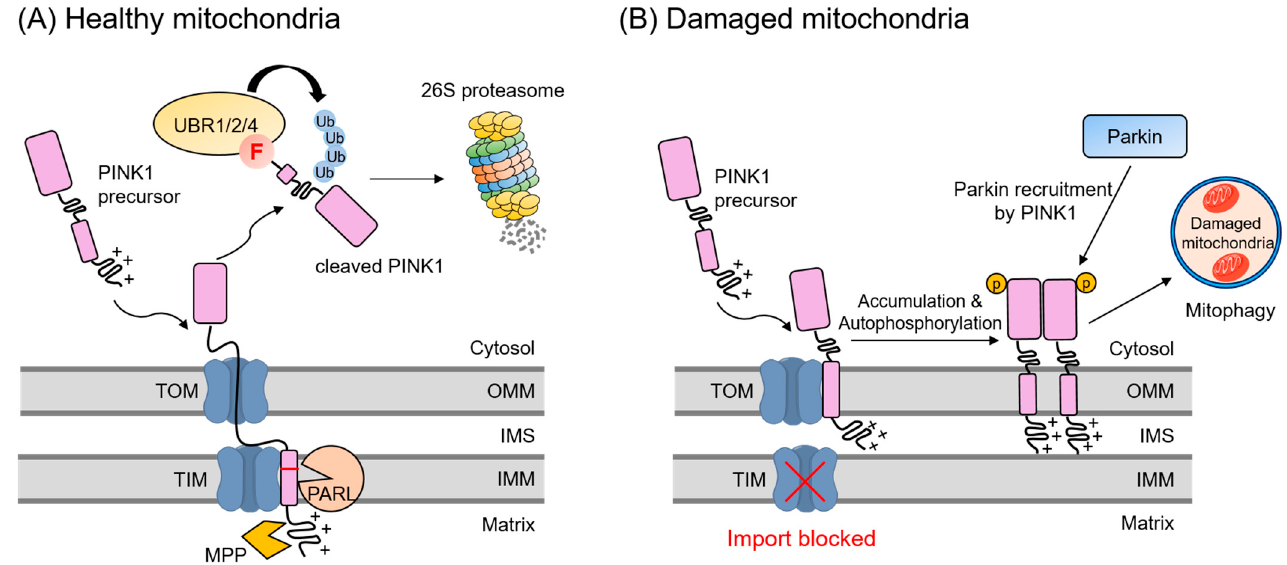
Figure 9. A schematic model describing mitochondrial quality control mediated by UBR1/2/4 in response to the mitochondrial damage. ( A ) PINK1 is continuously imported into healthy mitochondria through TOM and TIM complexes under steady-state conditions. After which, the precursor PINK1 is cleaved by MPP and PARL proteases, respectively. PARL cleaves between Ala103 and Phe104 of PINK1 to expose phenylalanine, a known type-2 destabilizing residue of the Arg/N-degron pathway, at the N-terminus. The cleaved PINK1 is released into the cytosol. Phe104-PINK is recognized by UBR1, UBR2, and UBR4 for ubiquitination and proteasomal degradation. ( B ) When depolarization or mitochondrial import is blocked, PINK1 accumulates on the OMM. The accumulation and autophosphorylation of PINK1 recruit Parkin E3 ligase from the cytosol to the mitochondria, leading to the degradation of damaged mitochondria through mitophagy.